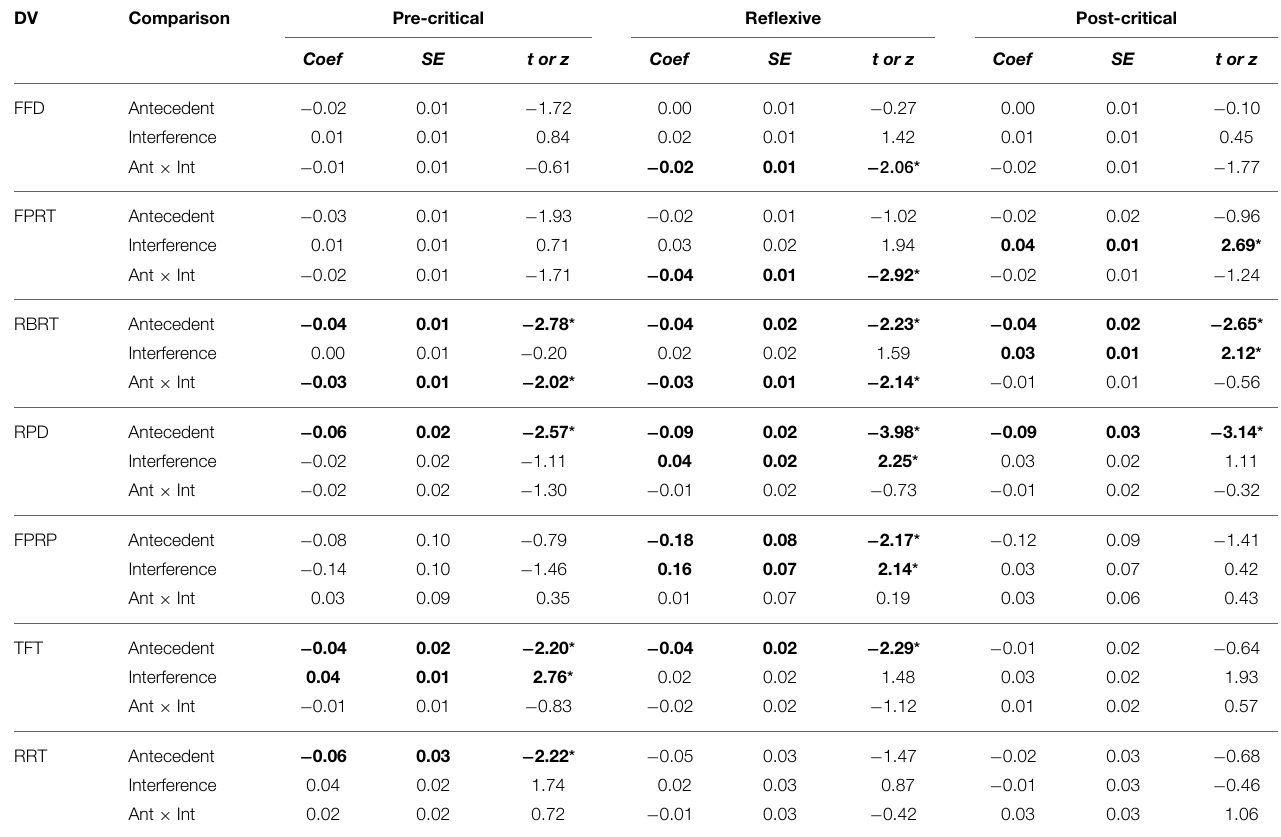
TABLE 4 | Experiment 1: Main effect of antecedent, main effect of interference and their interaction at the pre-critical ( ziji − 1), critical ( ziji ), and post-critical ( ziji + 1) regions for the dependent variables (DVs) first-fixation duration, first-pass reading time, right-bounded reading time, regression-path duration, first-pass regression probability, total fixation time, and re-reading time.